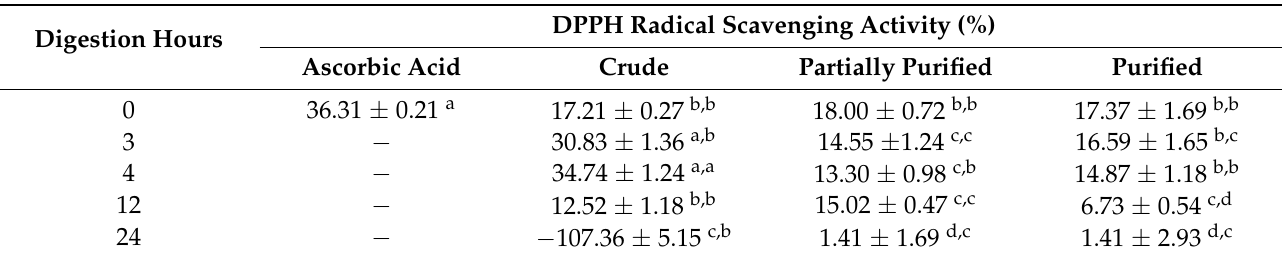
Table 3. DPPH radical scavenging activity (%) of crude, partially purified and purified protein extracts at different digestion hours